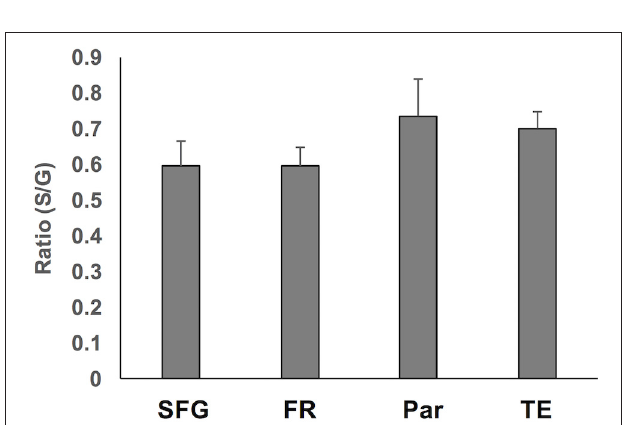
FIGURE 5 | Summary of the ratio of sulcal to gyral WMN counts across the four regions. These were not significantly different.